Question: Which visualization type does this figure use?
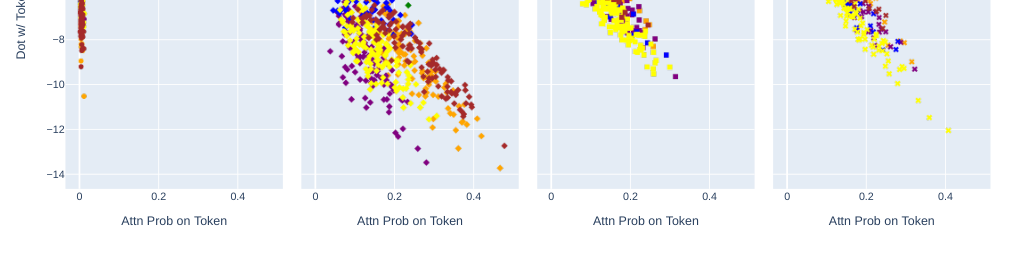
Answer: scatter